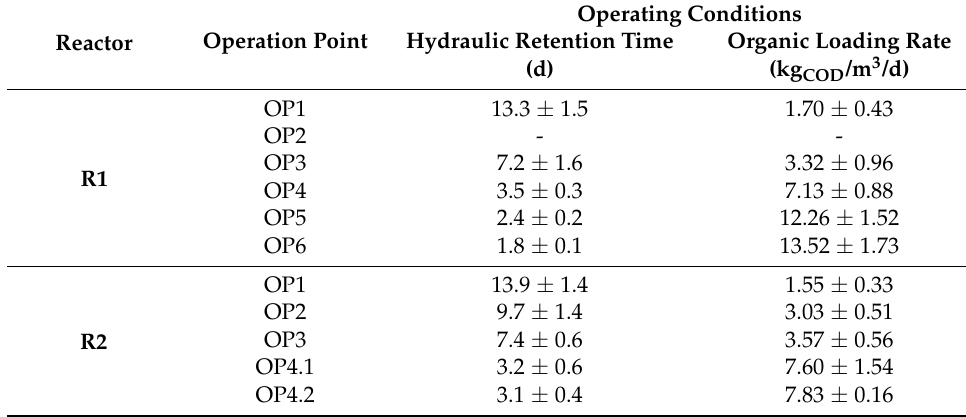
Table 3. Hydraulic retention times and organic loading rates of R1 and R2 at